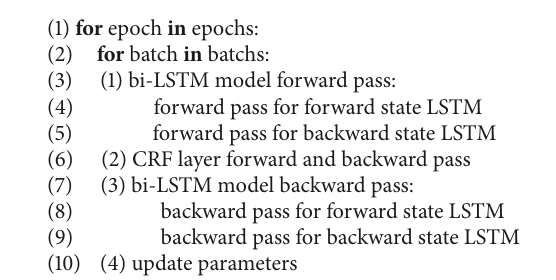
Algorithm 1: The model training procedure.